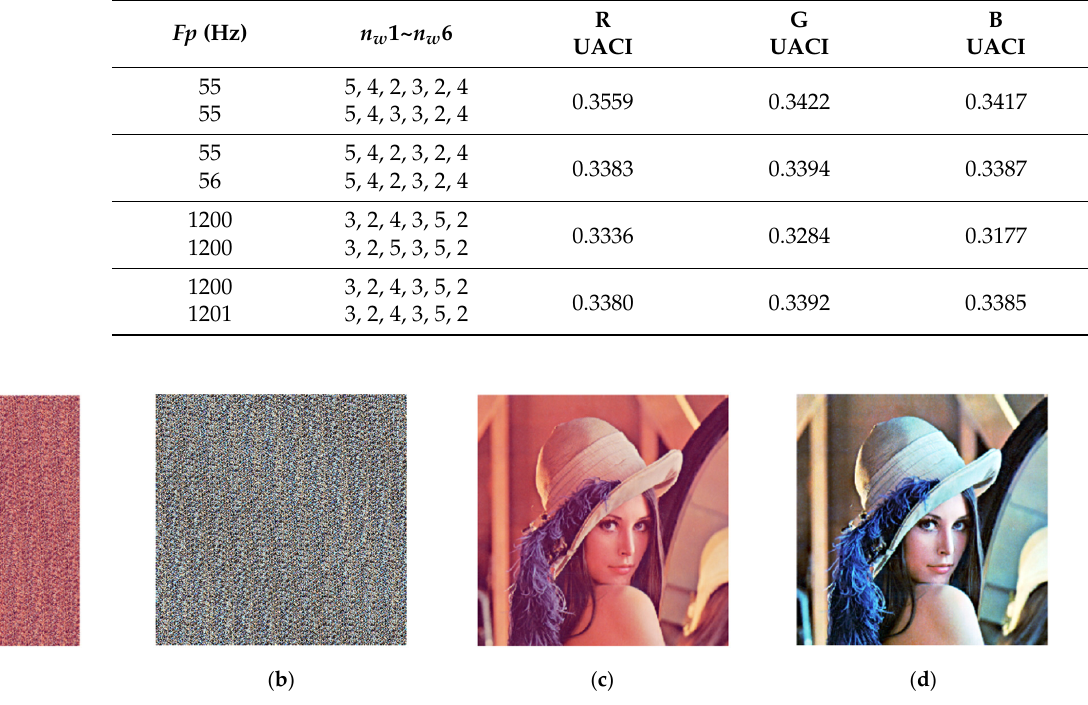
Figure 9. The optimized renderings. ( a ) Encrypted image before optimization; ( b ) Optimized encrypted image; ( c ) Decrypted image without optimization; ( d ) Optimized decrypted image.